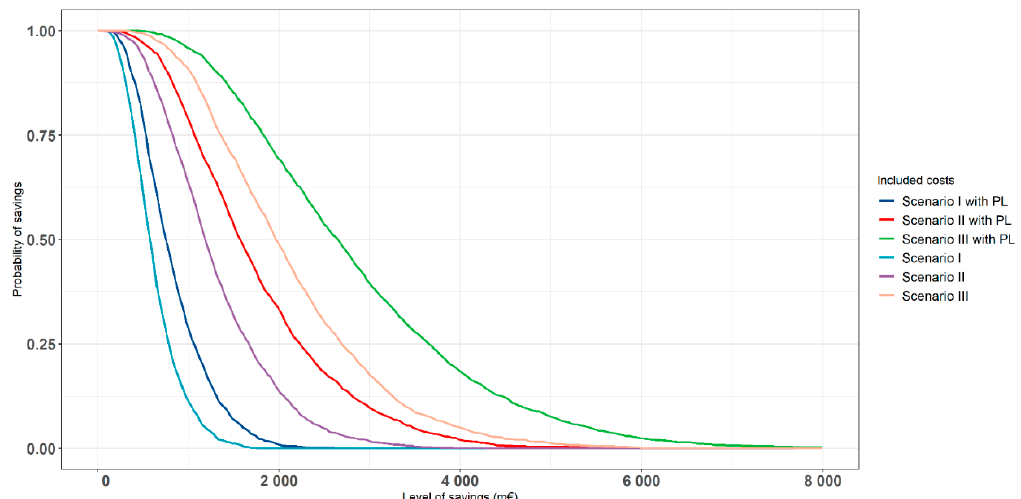
Figure 3. Results of the probabilistic sensitivity analysis showing the impact of applied time hori- zon on the distribution of expected population-level cost savings and gained QALYs on the X-Y-plane using Scenario I (current situation vs. a 10%-unit increase in the proportion of adult population using at least one whole grain servings a day) as an example. Blue, red, and green col- ors stand for 10-year, 20-year, and 30-year time horizons, respectively.